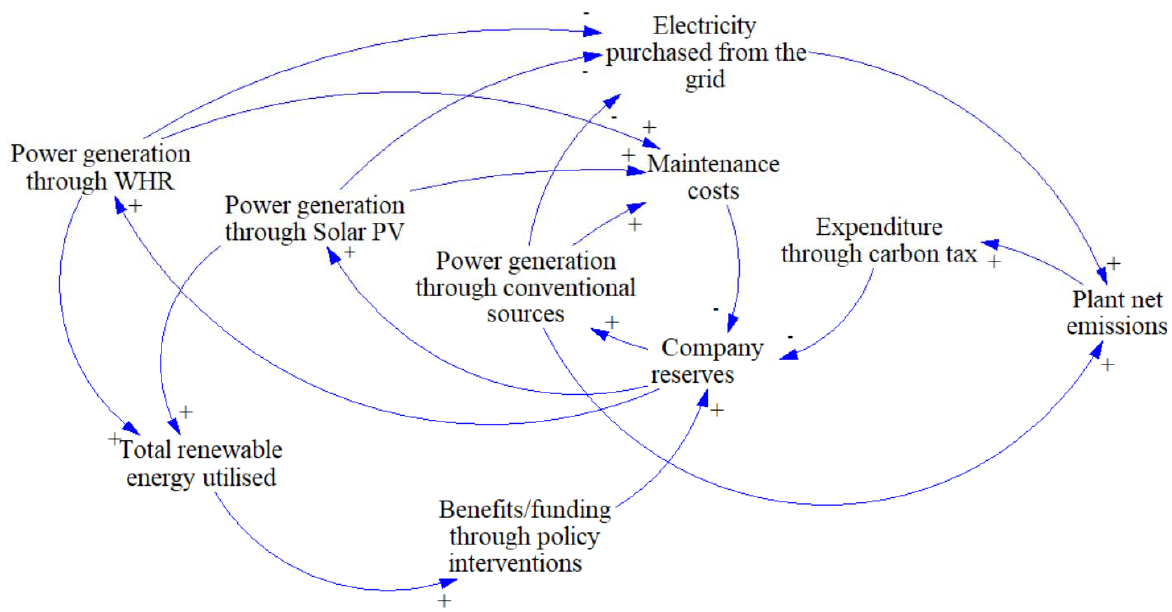
Figure 1. CLD of the proposed model for captive power generation in a cement plant.